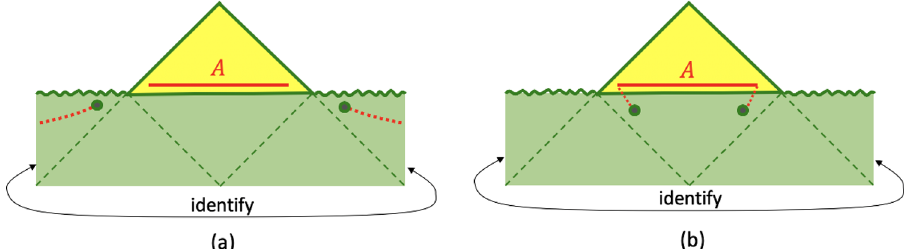
Figure 19 . We calculate the entropy of the interval A in the Milne case and examine the contri- bution from islands. We are identifying the left and right parts of the figure because we imagine that the geometry is the usual dS 2 spacetime with a compact spatial section. This means that the two black holes can be viewed as entangled with each other. (a) An island that is in the inside of the black hole region. (b) Another type of island which can lead to